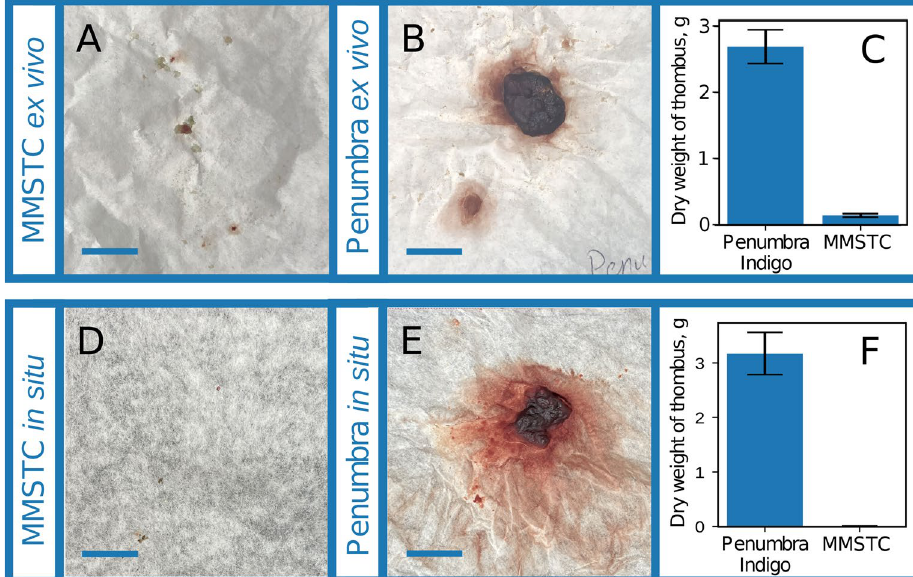
Figure 7. ( A ) Representative distal emboli collected from the MMSTC device ex vivo. ( B ) Representative distal emboli collected from the Penumbra Indigo 5 Fr device ex vivo. ( C ) The MMSTC device produced more than an order of magnitude less distal embolization than the Penumbra device under identical conditions. ( D ) Representative distal emboli collected from the MMSTC device in situ. ( E ) Representative distal emboli collected from the Penumbra Indigo 5 Fr device in situ. ( F ) The MMSTC device produced more than an order of magnitude less distal embolization than the Penumbra device under identical conditions. All scale bars: 2 cm.